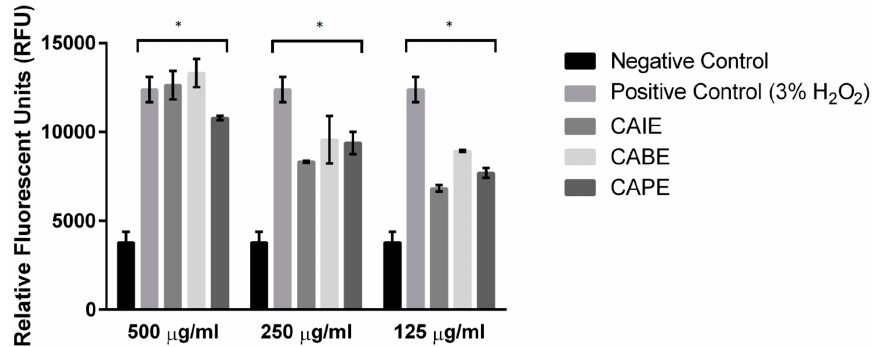
Figure 2. Quantification of intracellular reactive oxygen species in the presence of three inhibitory compounds. Paenibacillus larvae were stained with 10 µM 2 ′ ,7 ′ -dichlorodihydrofluorescein diacetate (H 2 DCFDA) before incubating the cells in the presence of minimum inhibitory concentrations of CAIE, CAPE, CABE and 3% H 2 O 2 (positive control) for 18 h incubation at 37 °C. Fluorescence was quantified using a microplate reader at 495 nm/527 nm (Ex/Em). Data presented are mean RFU ± SD ( n = 2–6). Asterisks represent a significant difference between control cells and cells exposed to either CAIE, CAPE, CABE and 3% H 2 O 2 ( p < 0.05). Biomolecules 2019 , 9 , x FOR PEER REVIEW